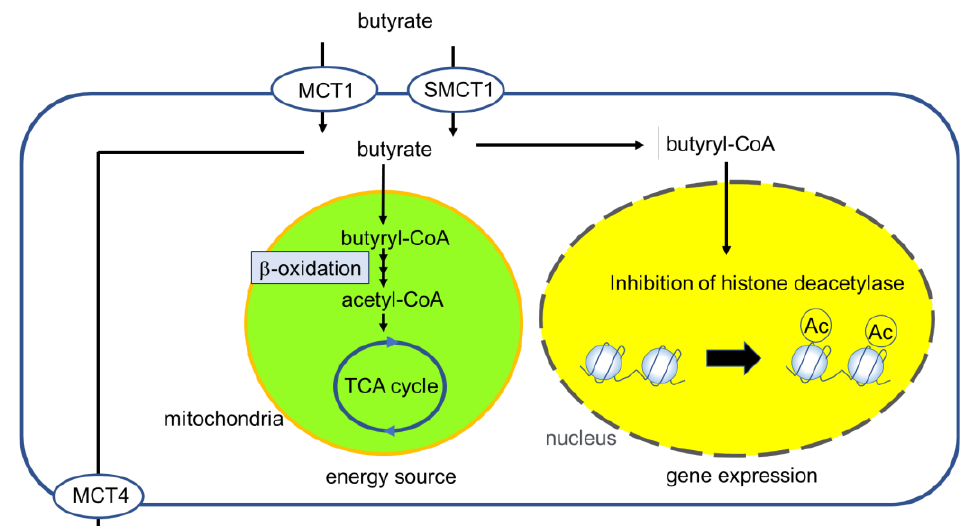
Figure 1. Overview of butyrate uptake, dynamics, and physiological effects in intestinal epithelial cells (IECs). Butyrate fermented by microbiota is transported to IEC by monocarboxylate transporter 1 (MCT1) and sodium-coupled monocarboxylate transporter 1 (SMCT1). By β -oxidization in the mitochondria, butyrate is metabolized to acetyl-CoA. Unmetabolized butyrate inhibits histone deacetylase and is transported into the lamina propria.